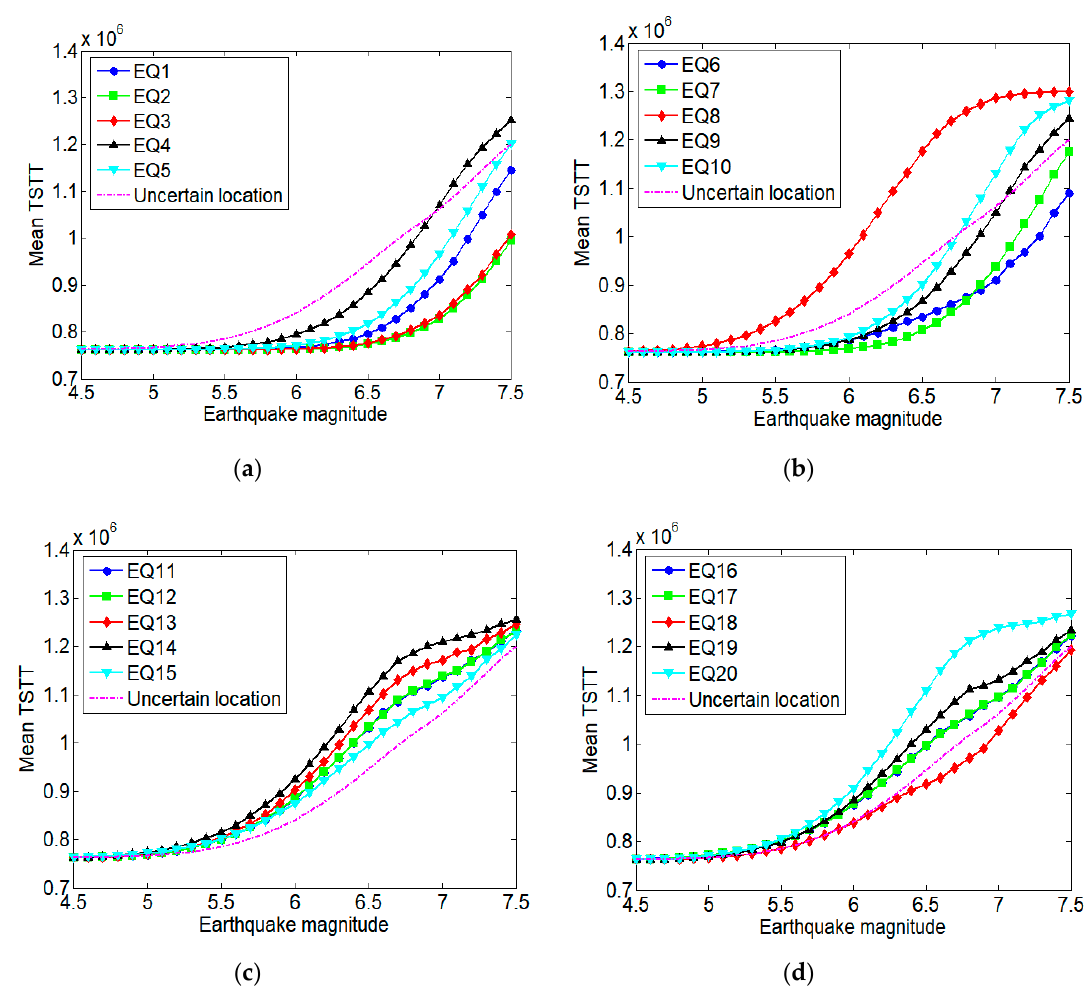
Figure 10. Evaluation of mean TSTT with different epicenters and earthquake magnitude. ( a ) Locations 1 to 5, ( b ) locations 6 to 10, ( c ) locations 11 to 15, and ( d ) locations 16 to 20.